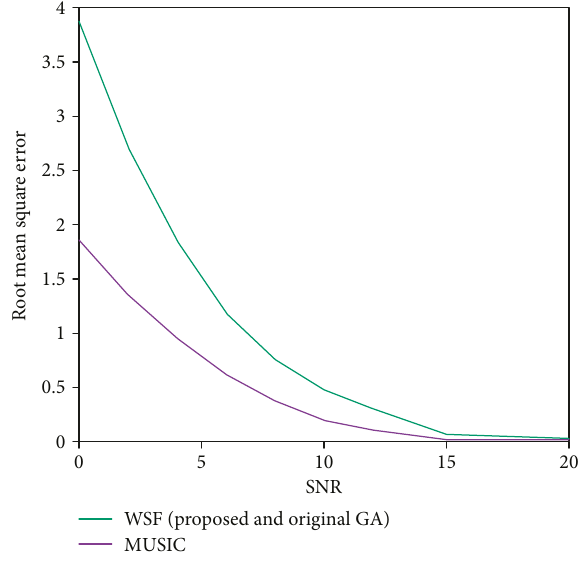
Figure 2: RMSE of the estimation of WSF and